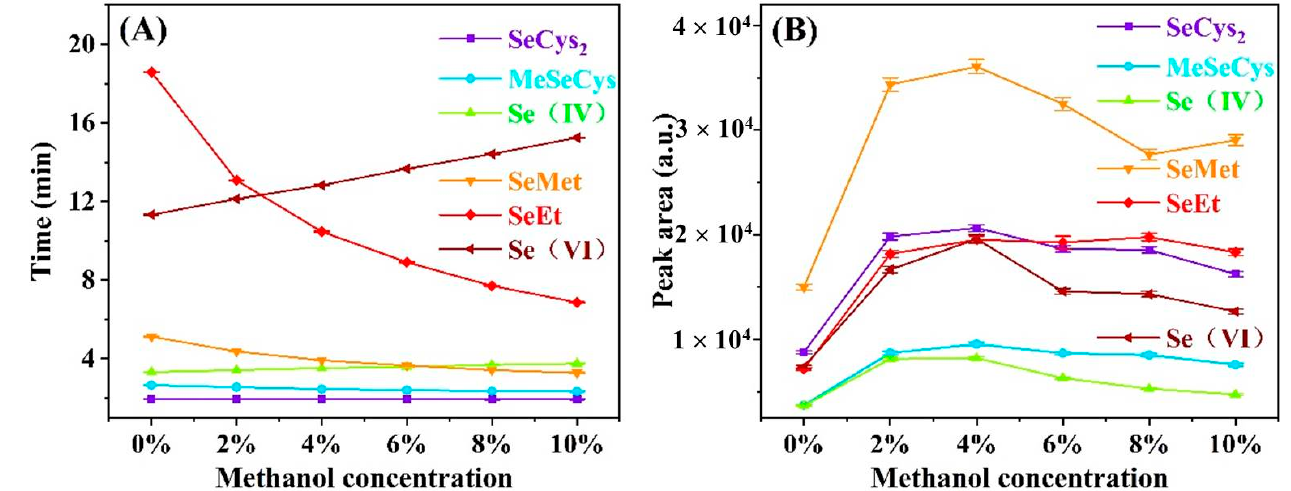
Figure 1. The effect of methanol in mobile phases on ( A ) retention time and ( B ) peak area of SeCys 2 , MeSeCys, Se(IV), SeMet, SeEt, and Se(VI). SeCys 2 : 200 ng mL − 1 , MeSeCys: 100 ng mL − 1 , Se(IV): 100 ng mL − 1 , SeMet: 500 ng mL − 1 , SeEt: 200 ng mL − 1 , Se(VI): 100 ng mL − 1 .